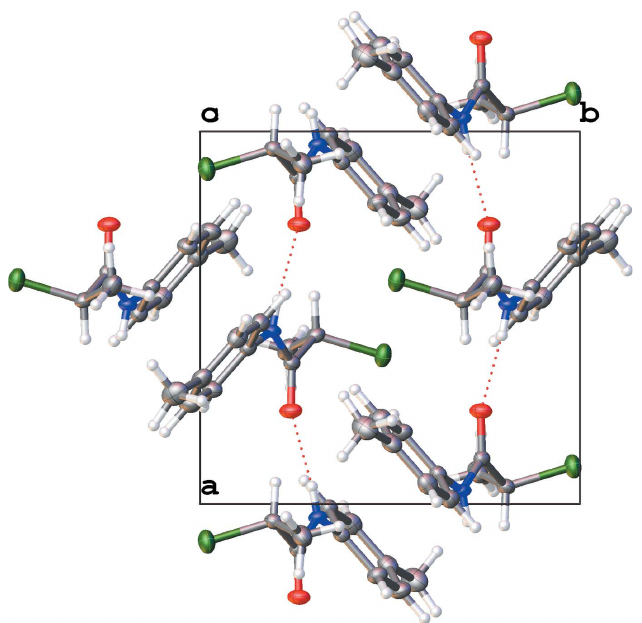
Figure 3 Hydrogen-bonding network represented by dotted lines of one layer in the cell viewed normal to the (001) plane. Displacement ellipsoids are shown at the 50% probability